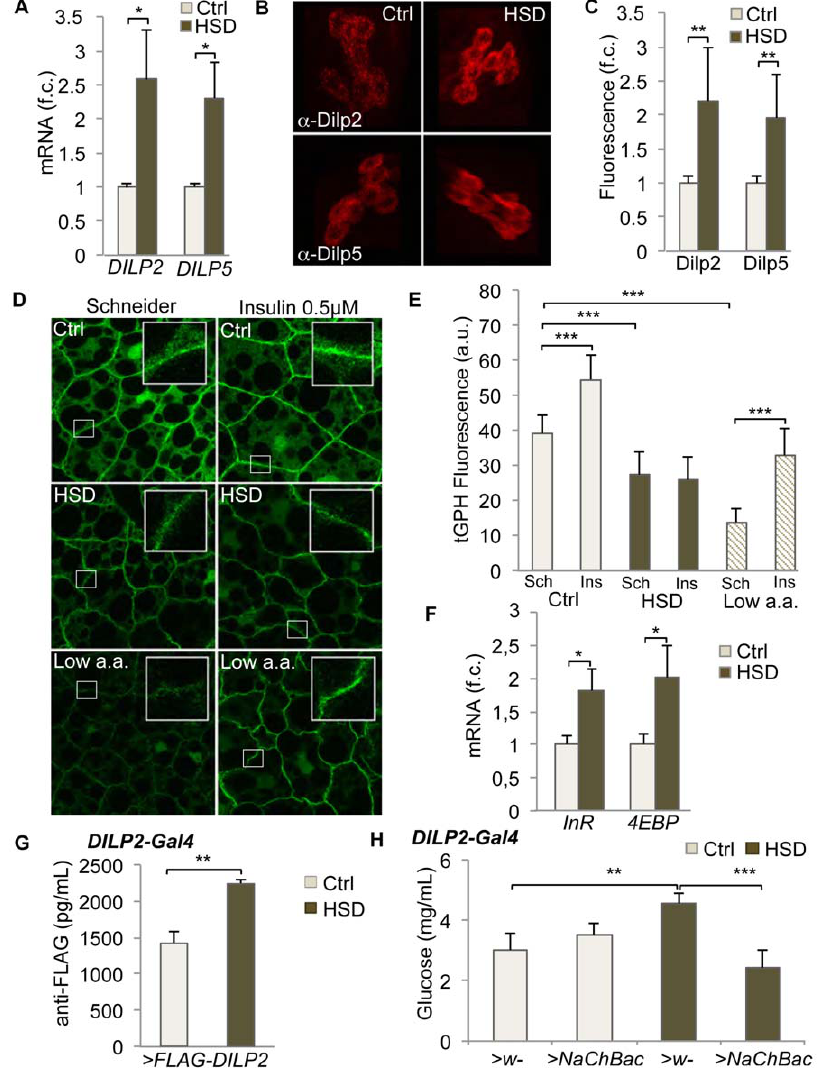
Figure 2. High Sugar Diet induces peripheral Dilp-resistance. (A) A two-fold increase in DILP2 and DILP5 transcription is observed in larval brain upon feeding a HSD (fold changes are presented, f.c.). (B) Dilp2 and Dilp5 immuno-staining of the insulin-producing cells (IPCs) in L3 larvae fed ctrl and HSD. (C) Quantification of fluorescence in IPCs (fold changes are presented, f.c.). (D) and (E) Insulin stimulation test of fat body explants from control or HSD-fed larvae. After a short incubation to human insulin (0,5 m M, 20 min) the amount of tGPH fluorescence was quantified as an evaluation of insulin sensitivity. In D, representative images of fat bodies after incubation. Cell membranes outlined with the tGPH marker are shown in inserts. (F) The dFoxo targets Inr and 4EBP are upregulated in HSD conditions, indicative of a general reduction of IIS in HSD-fed larvae (mid-L3 larval samples, fold changes are presented, f.c.). (G) Circulating Dilp2-Flag in the hemolymph of larvae fed either control of HSD. Larvae express a Flag- tagged Dilp2 in the IPCs ( Dilp2-Gal4 . Flag-Dilp2 ) and circulating levels of Dilp2-Flag are quantified using an Elisa method (see Material and Methods). (H) Forced expression of a bacterial sodium channel in the brain IPCs during larval development ( Dilp2-Gal4 . NaChBac, see (6)) promotes Dilps secretion and prevents HSD-induced